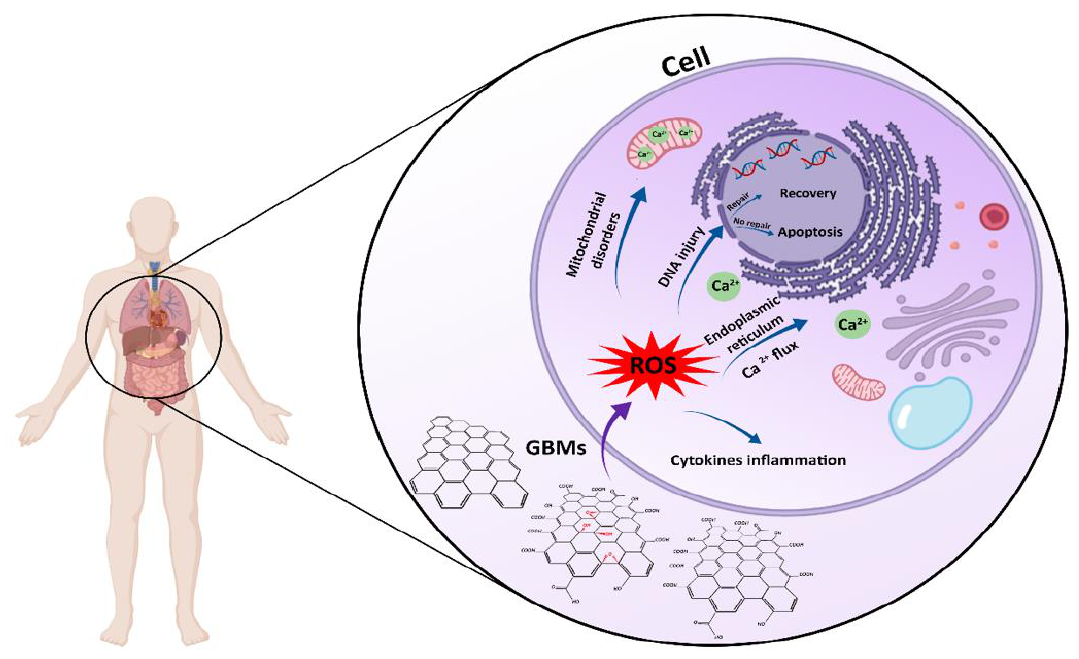
Figure 8. Schematic illustration of the cellular toxicity of GOBMs when exposed to the cell. GOBMs enter the cell through various pathways, which affects their shape, size, and surface chemistry and eventually results in ROS production. An increased ROS level may cause mitochondrial membrane depolarization and Ca 2+ release; lipid, protein, and DNA damage; and inflammation response by releasing cytokines and chemokines.